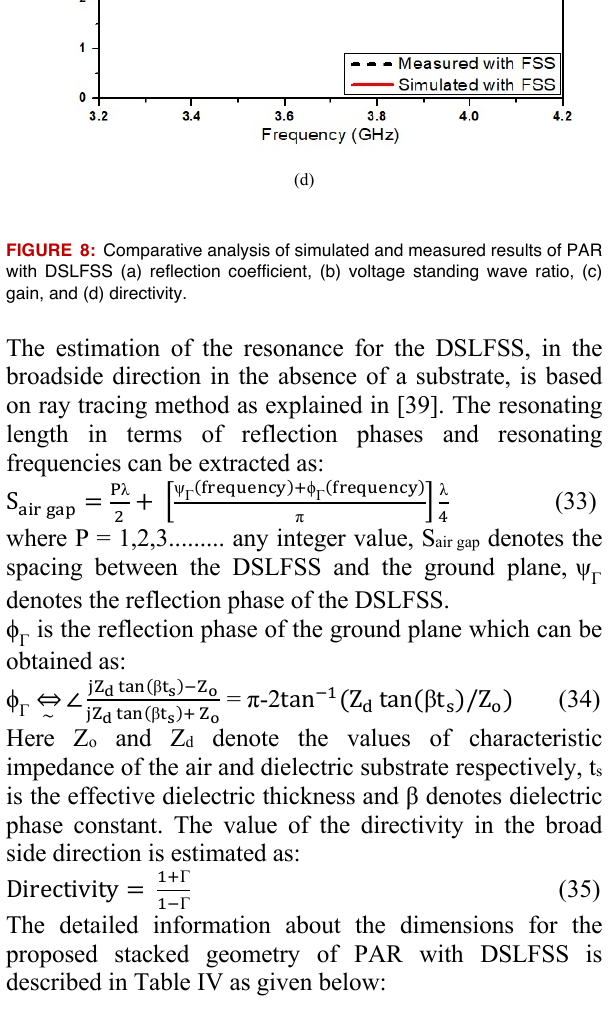
TABLE IV. Dimensions of the proposed PAR with